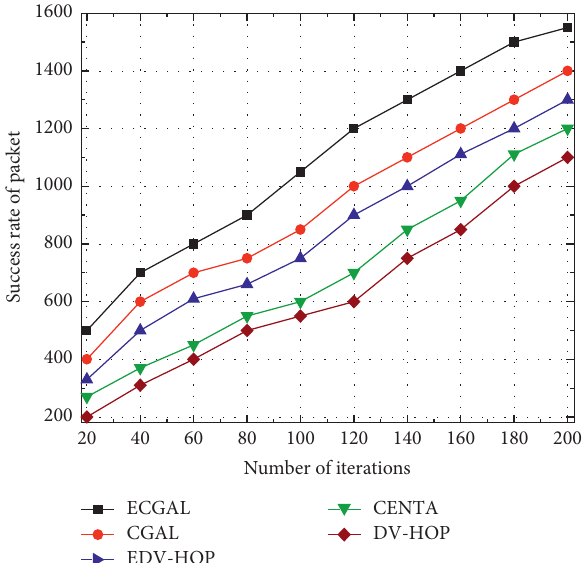
Figure 17: Localization coverage against network connectivity of nodes.